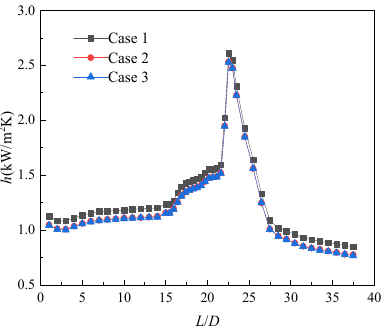
Figure 3. Grid independence validation of the U ‐ tube.